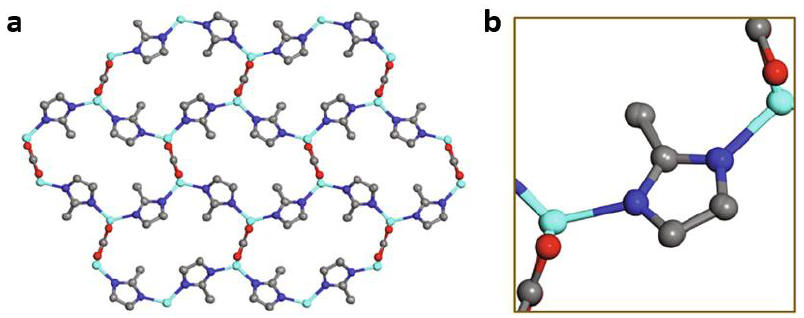
Figure 7. Comparison between the structural model of BSA@ZIF-C refined from cRED data and that of ZIF-CO3-1 from SCXRD data [95]. ( a ) The structures are stacked together, viewed along the c-axis. ( b ) An enlarged figure shows the connection of a mIM linker to Zn(II) cations, illustrating the accuracy of the model obtained from the cRED data. Blue spheres: N; red spheres: O; gray spheres: C; cyan spheres: Zn atoms. Reproduced from ref. [95] with permission from the Royal Society of Chemistry, copyright